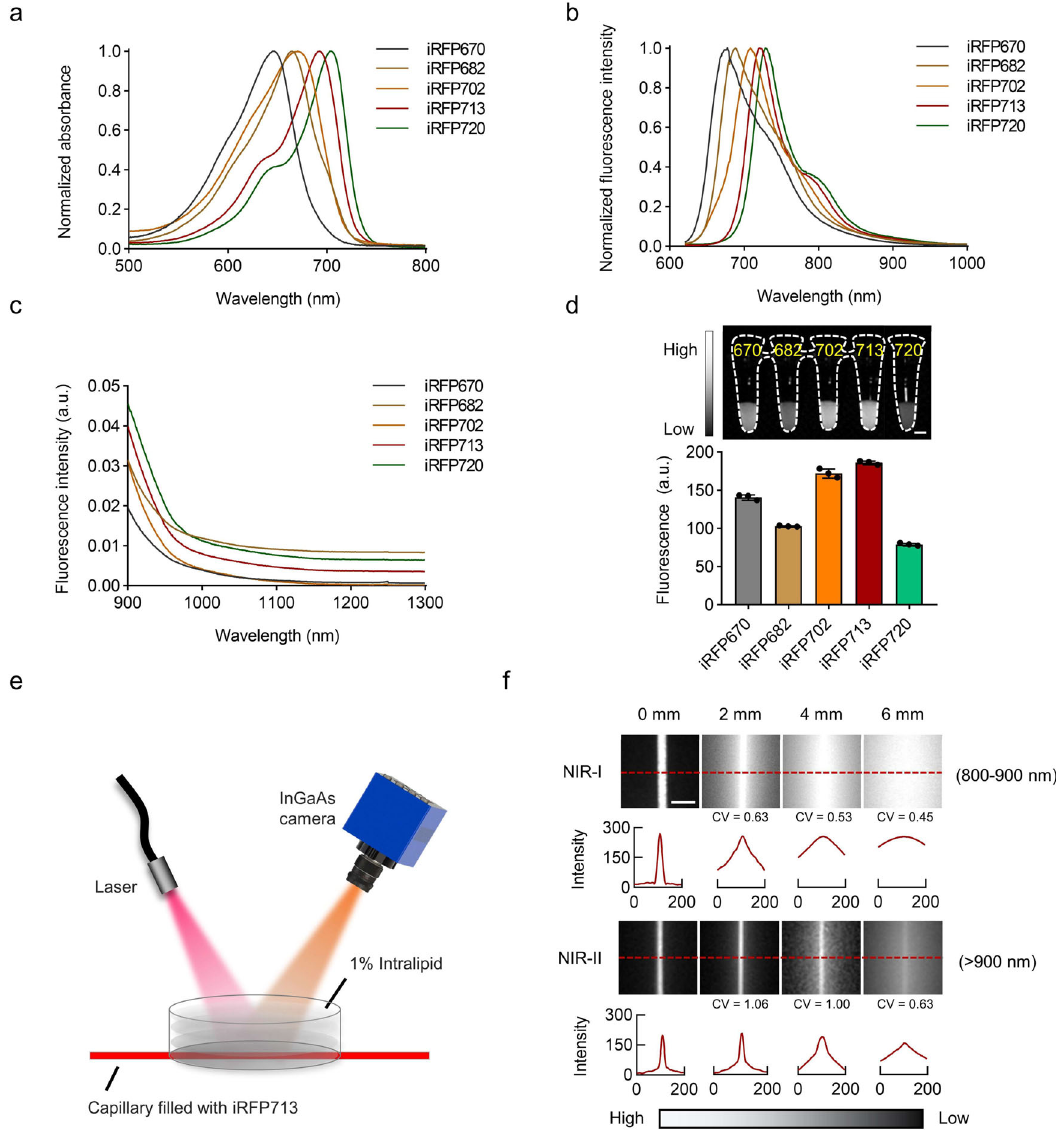
fl uorescenceimages ( f ) of a capillary tube containing iRFP713 immersed at various depths in 1% intralipid, recorded under different LP fi lters (1mgmL − 1 , 690nm Ex and 800-900nm/>900nm Em, respectively). Exposure times: (NIR-I) 0mm and 2mm: 10ms; 4mm: 80ms; 6mm: 100ms. (NIR-II) 0mm and 4mm: 10ms; 2mm: 5ms; 6mm: 100ms. Corresponding cross-sectional fl uorescence intensity pro fi les alongtheindicatedred-dashedlineswereevaluatedforeachchannelateachdepth. Scale bars: 5mm ( d, f